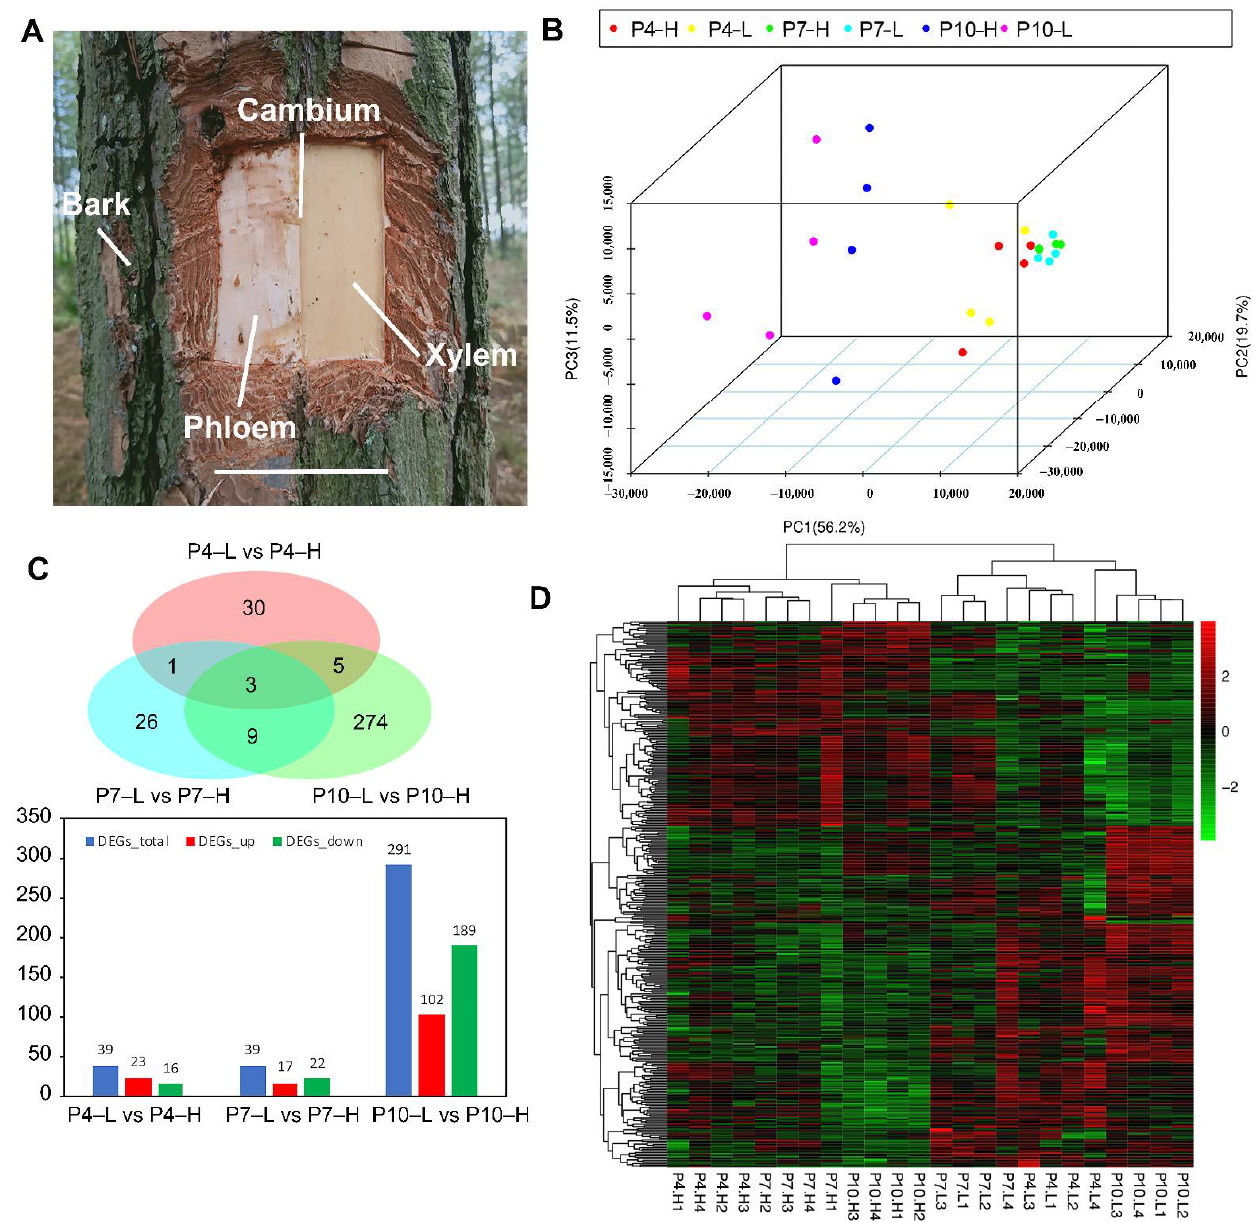
Figure 1. The overall DEGs between the high- and low-yielding slash pines. ( A ) Detailed sampling sites of high- and low-yielding slash pines for RNA-seq. White bar = 10 cm. ( B ) Principal component analysis (PCA) of 24 samples based on the DEGs (Log2 ≥ 1 or ≤− 1). ( C ) Venn diagram and histogram. The venn diagram shows the number and distribution of DEGs between high- and low-yielding slash pines in April, July, and October, and the histogram indicates DEGs numbers. The blue stands for the total DEGs, red means the up-expressed DEGs, and green is the repressed DEGs. ( D ) Heat map exhibits the congregation of relative expression levels in different groups.